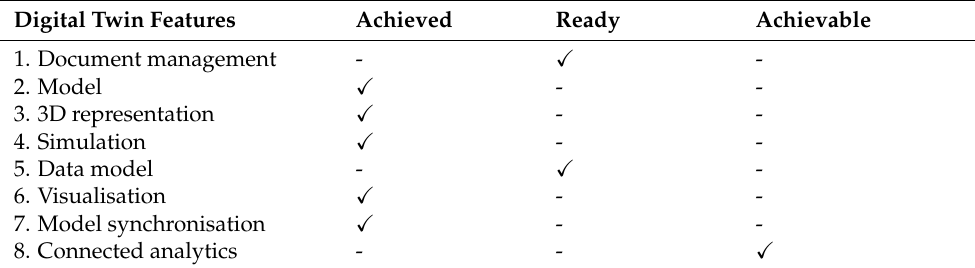
Table 2. The features of the digital